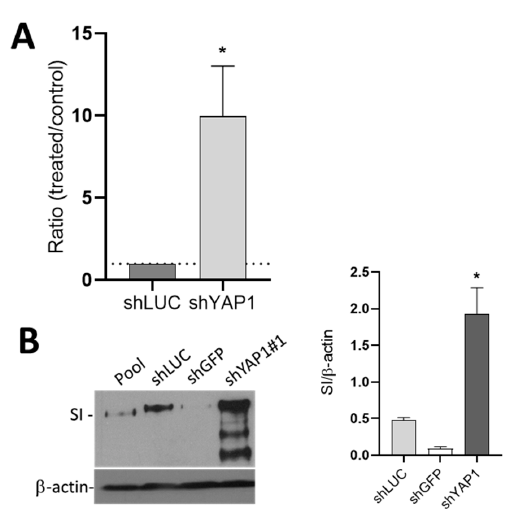
Figure 9. The effect of shYAP1 expression on Caco-2/15 cell differentiation. ( A ) Transcript expression of the absorptive cell marker SI in Caco-2/15 cells expressing shYAP1 relative to shCtrl (shLUC). ( B ) Western blot analysis and data compilation showing higher expression of SI in shYAP1 Caco-2/15 cells relative to shCtrl at five days post-confluence. β –actin was used as a loading control. Statistical comparison between shYAP1 vs. shLUC: * p < 0.05.